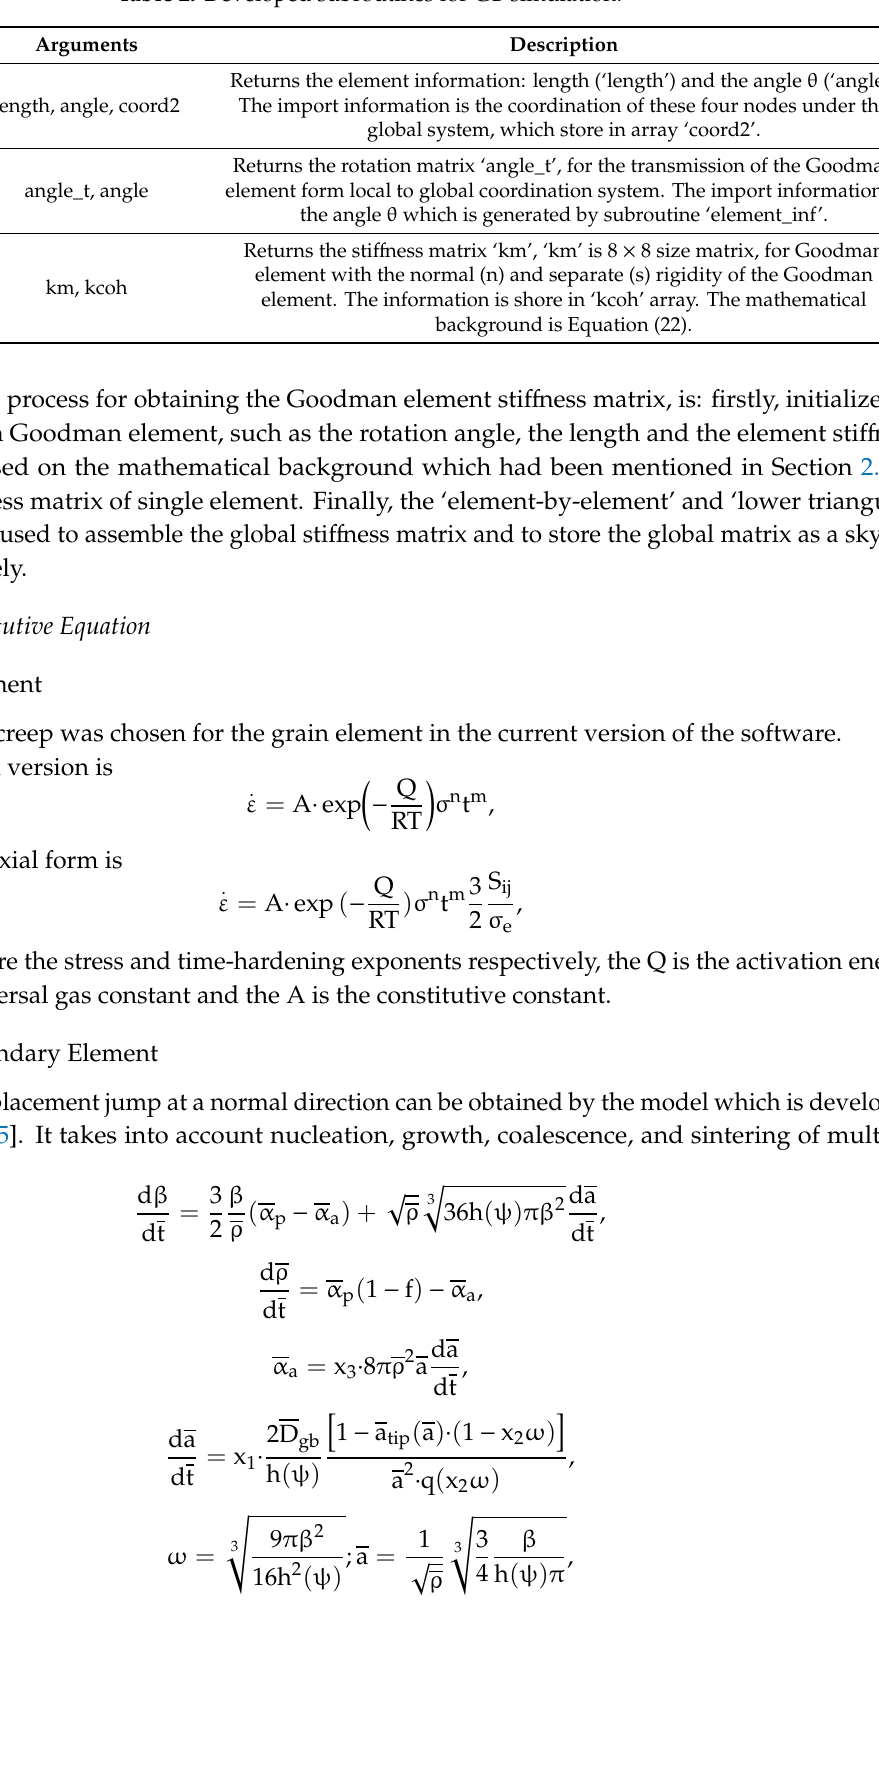
Table 2. Developed subroutines for GB